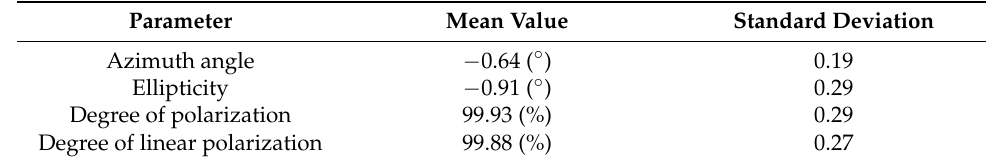
Table 2. Polarimetric characteristics of the illumination used for performing the experiments. Parameter Mean Parameter